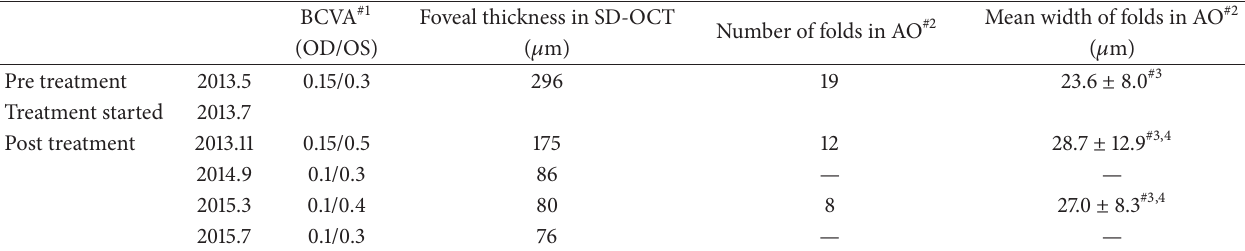
Table 1: Time course of the clinical data.